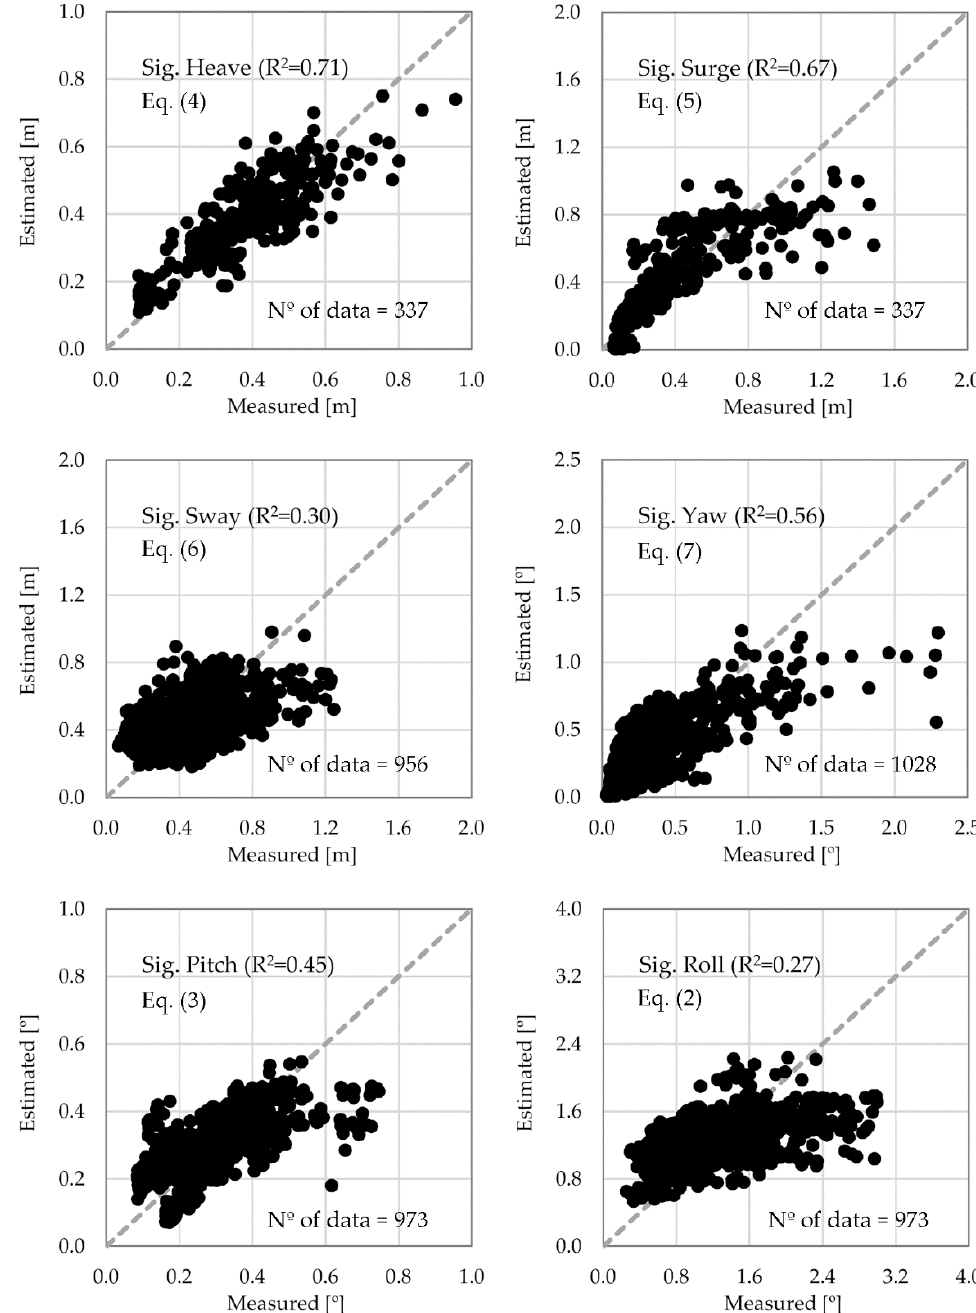
Figure 8. Scatter plots of measured values versus predicted values for the multivariate linear models fitted to significant vessel movements.